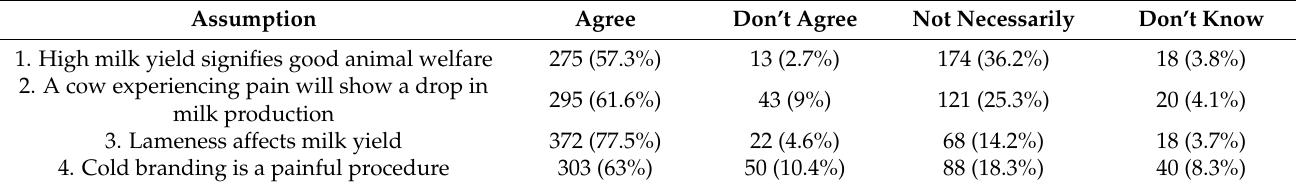
Table 3. Distribution of farm workers’ responses to assumptions regarding pain, and effect of pain on milk yield ( n = 483).